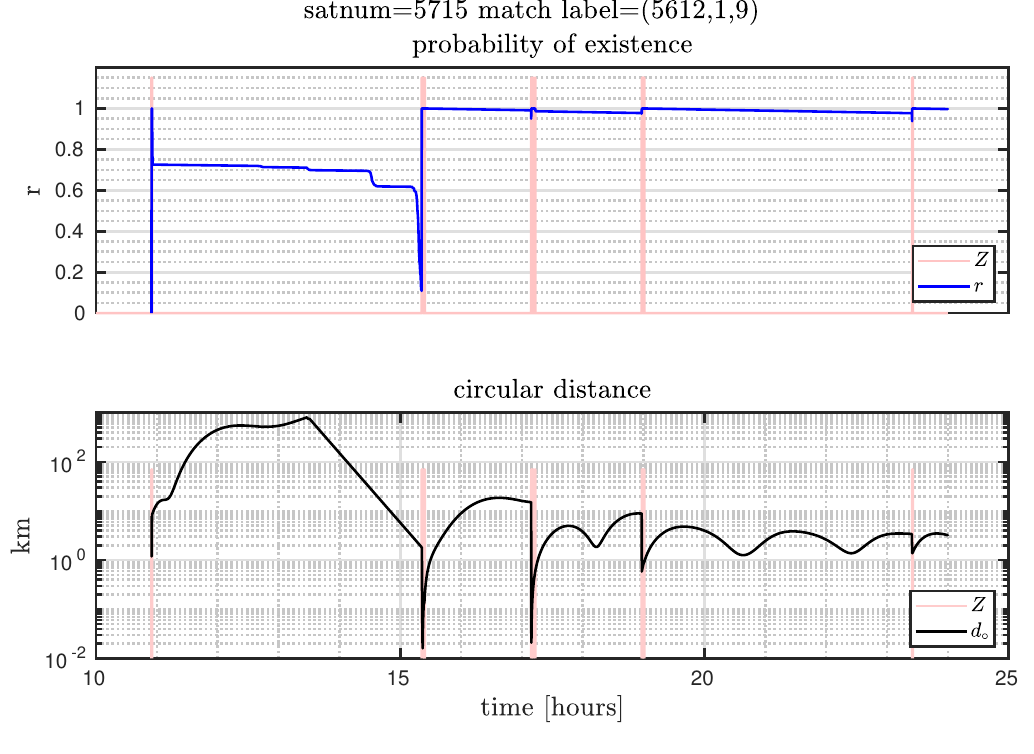
Figure 8. Trajectory results for satnum = 5715, first MC